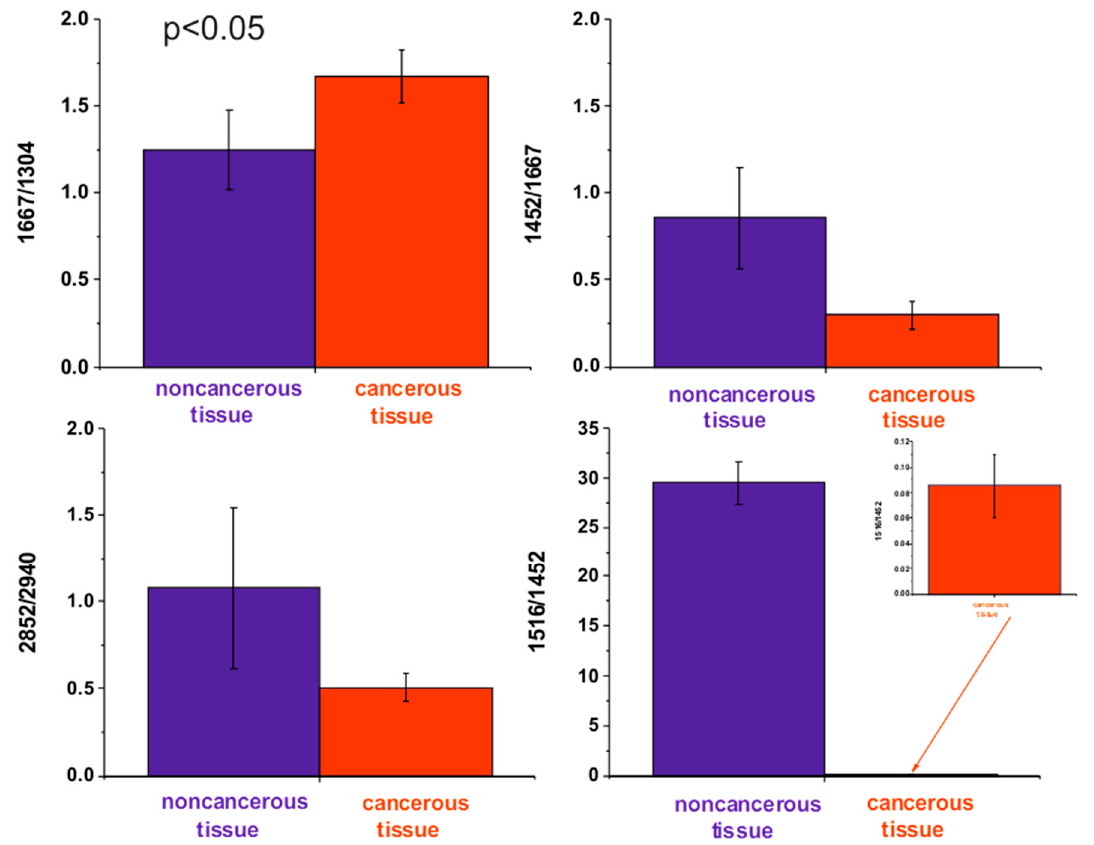
Figure 5. The average ratios of lipids/proteins/carotenoids constituents for the noncancerous and the cancerous human colon tissue samples for tubular carcinoma of the colon, cancer stage G2.